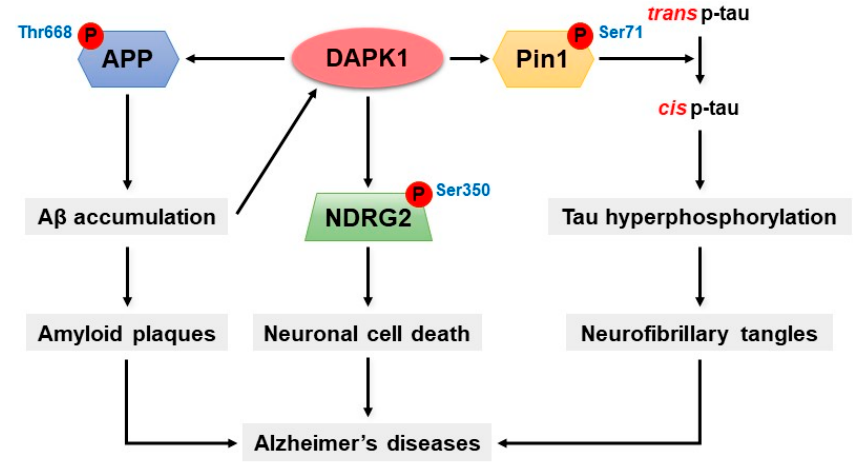
Figure 3. The molecular mechanism of DAPK1 in AD. The activation of DAPK1 triggers the phosphorylation of APP at Thr668, shifting APP processing toward the amyloidogenic pathway and A β production. Moreover, DAPK1 considerably inactivates Pin1 activity through its phosphorylation at Ser71. The inactivation of Pin1 increases cis p-tau and induces the hyperphosphorylation of tau. Furthermore, DAPK1 regulates NDRG2 phosphorylation at Ser350, which may lead to AD through significant cell